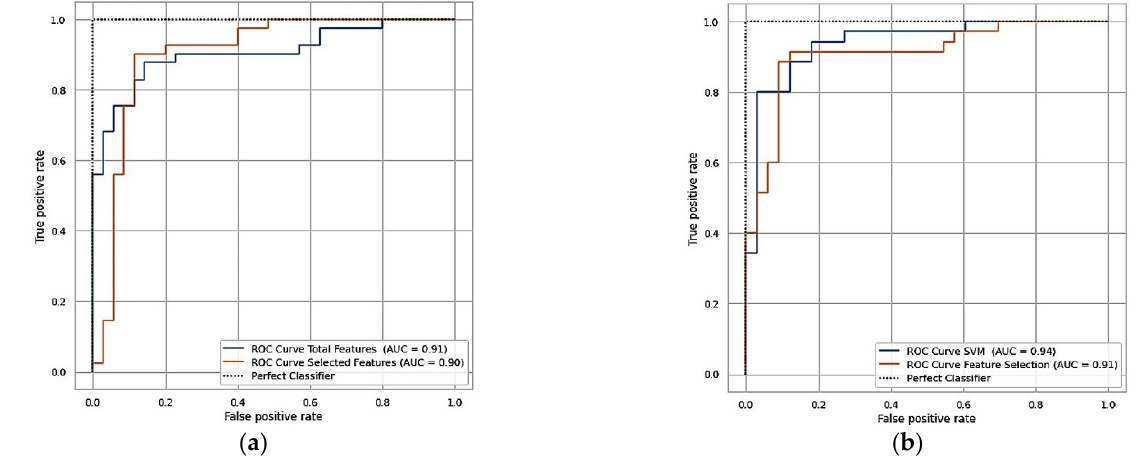
Figure 8. AUC and ROC analysis. ( a ) Cleveland dataset; ( b ) Statlog dataset.